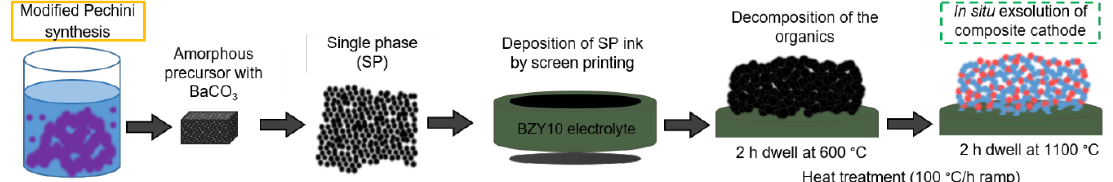
Figure 2. Schematic illustration of the in situ exsolution of La 1-x Ba x CoO 3- δ -BaZr 1-z-y Y z Co y O 3- δ cathode materials on the surface of the electrolyte. The cathode processing and exsolution of the composite occur in one step.